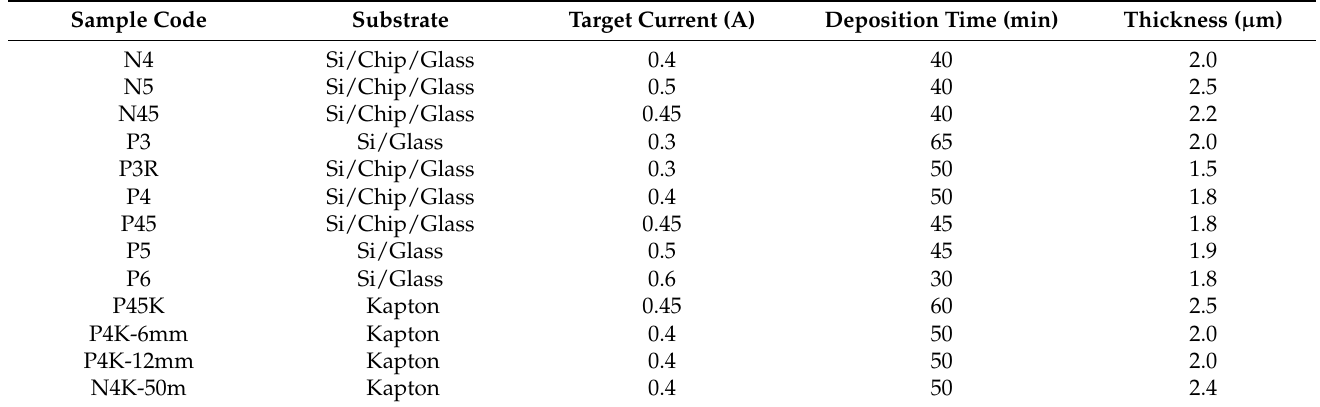
Table 2. Sample codes and deposition